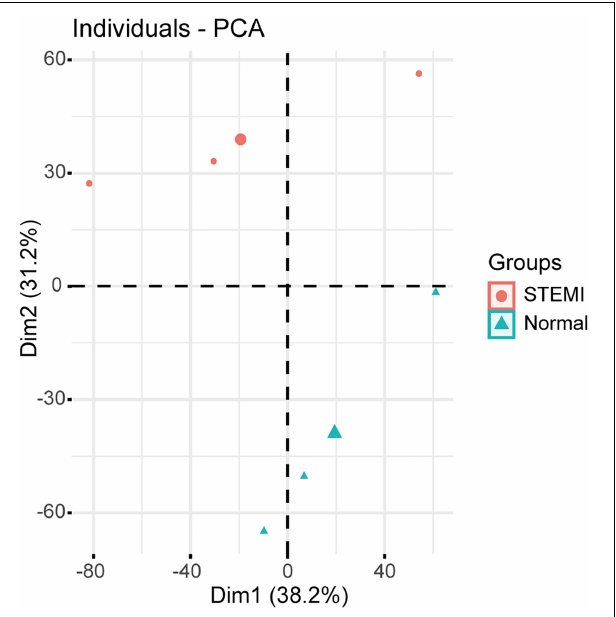
FIGURE 1 | Relative distances between samples from AMI patients (red symbol) and controls (green symbol) by PCA. The top two principal components of the circRNA expression